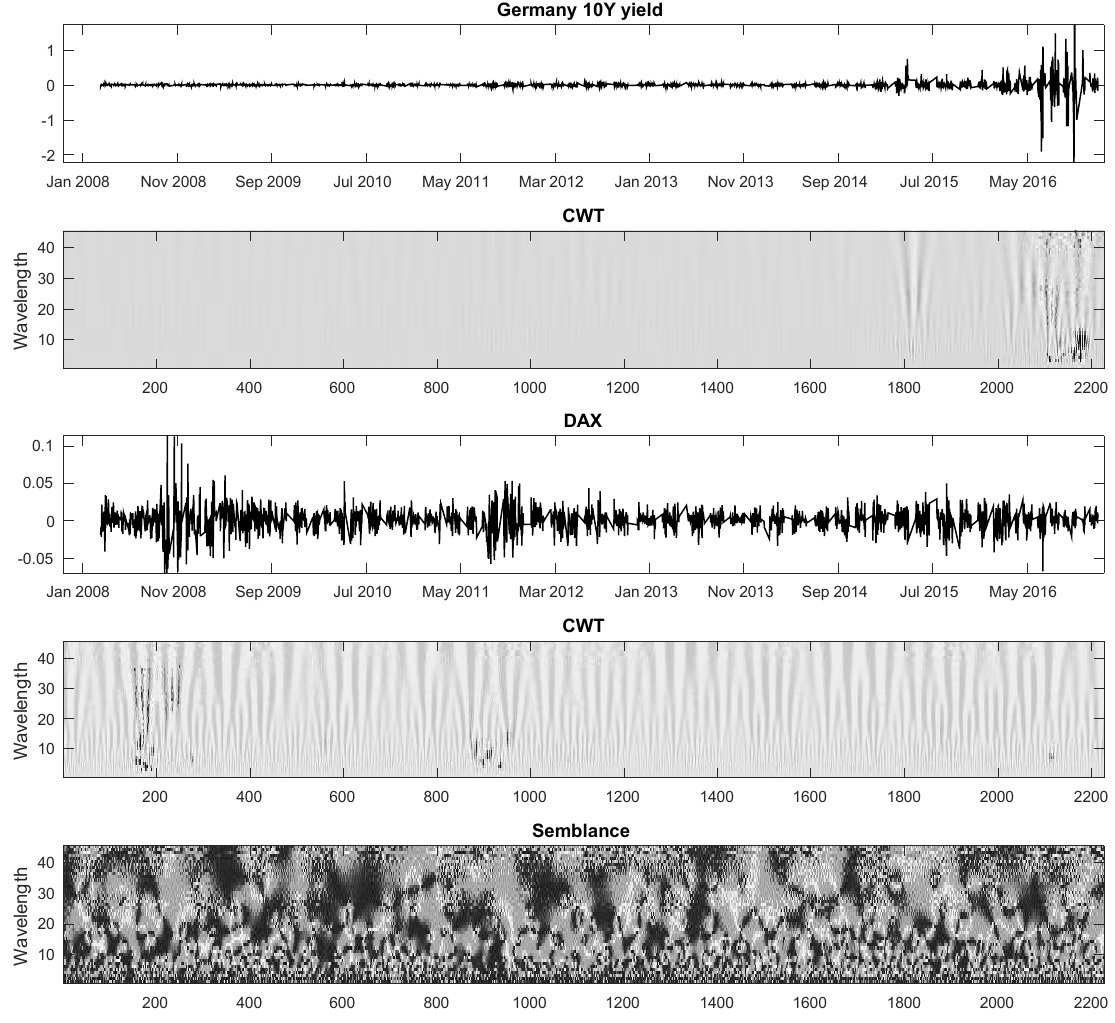
Figure 1. German 10 year bond yield and DAX